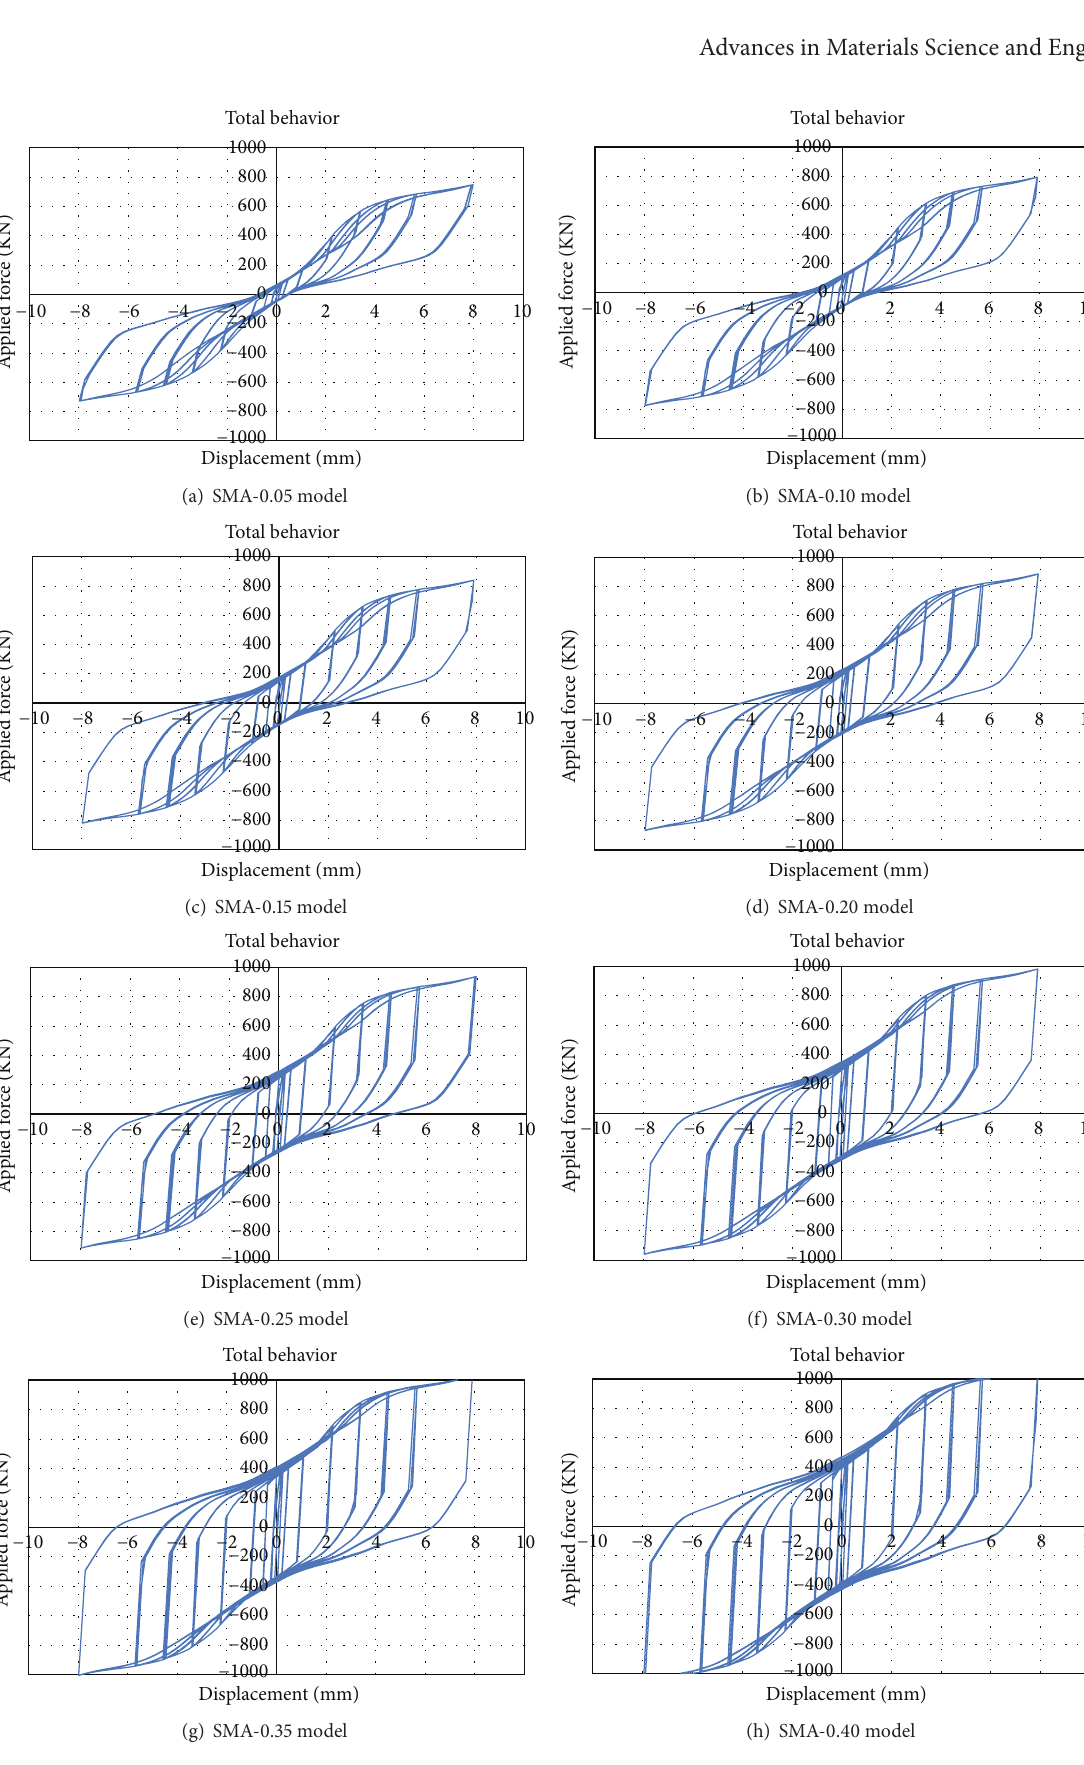
Figure 11: Total behavior of the superelastic SMA bearing systems with the friction